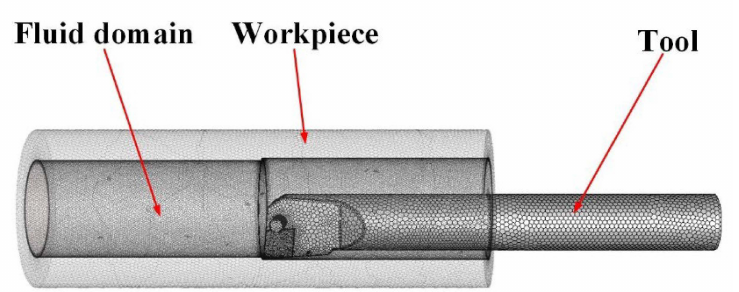
Figure 4. The mesh of simulation model of fluid-solid coupling heat transfer.